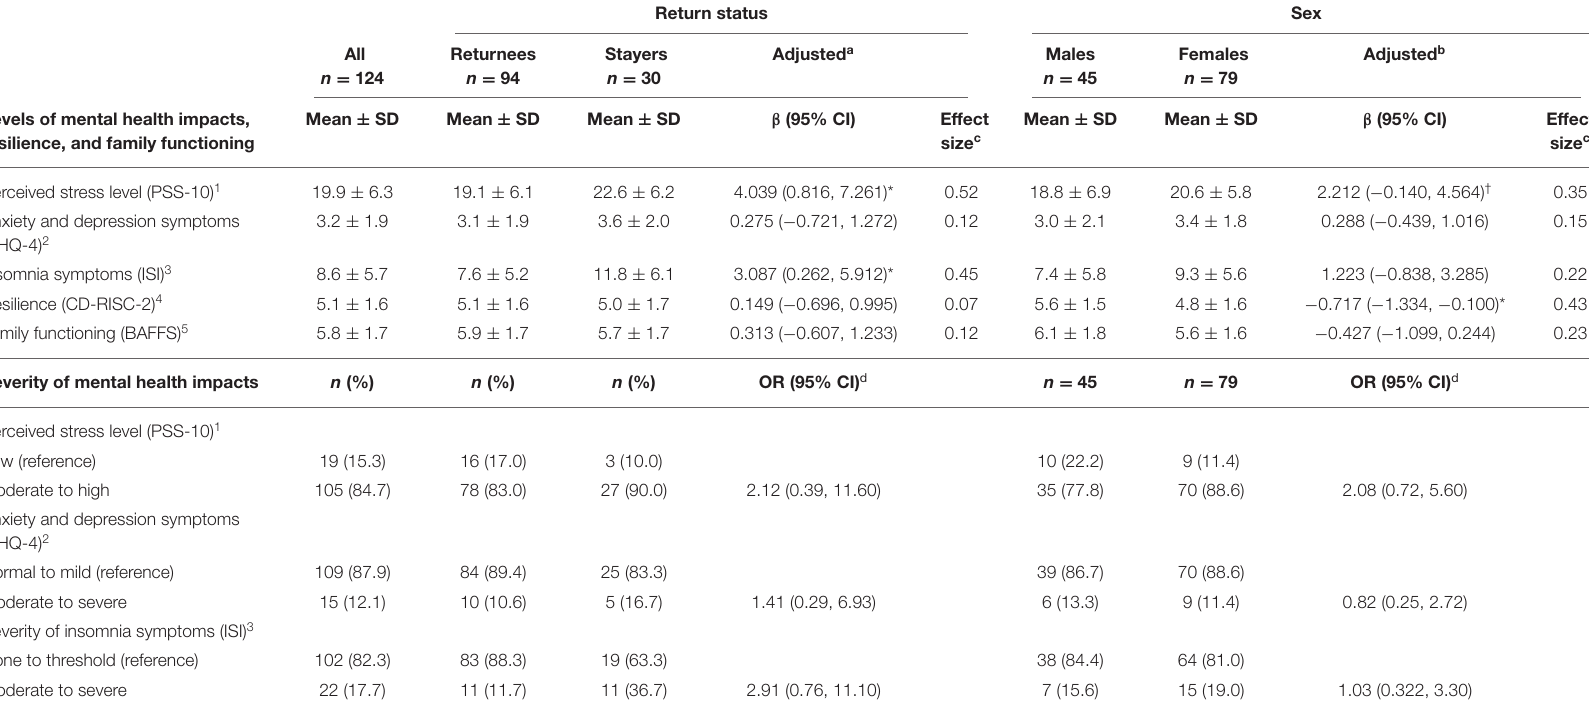
TABLE 3 | Levels and severity of mental health impacts, resilience, and family functioning in the total student sample and